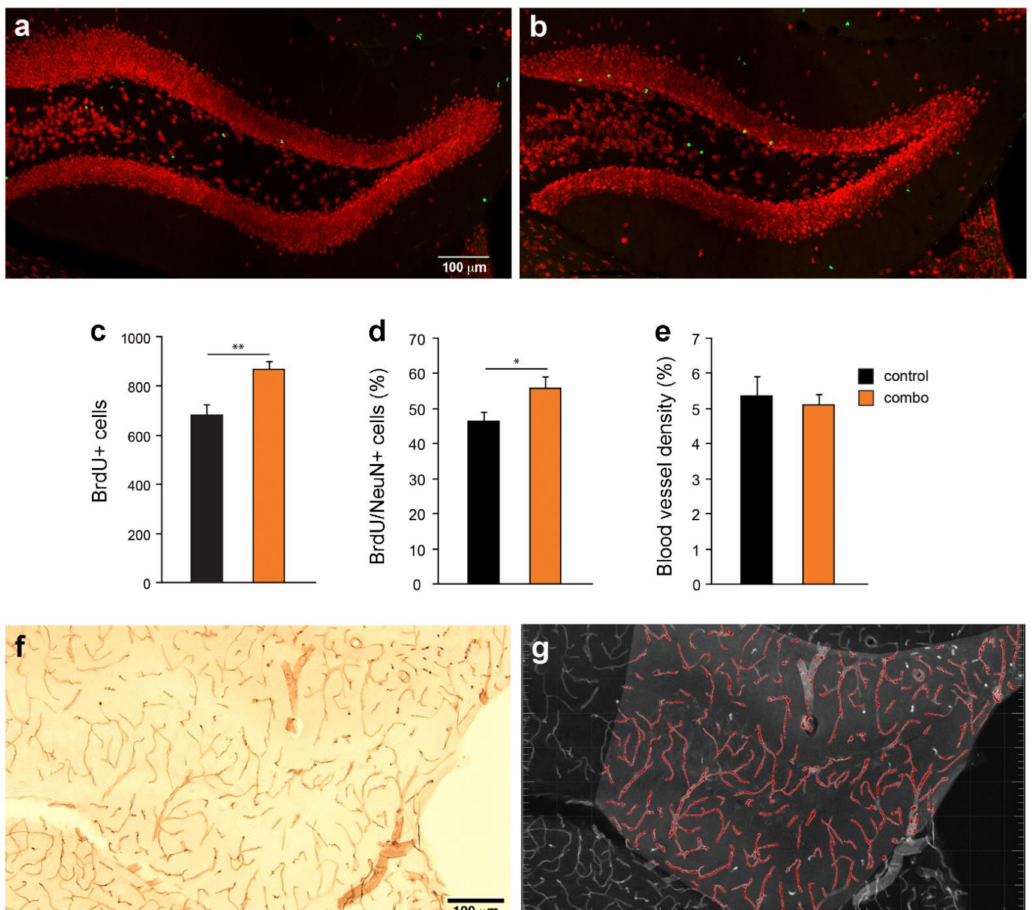
Figure 2. Effects of compound treatment on adult hippocampal neurogenesis and angiogenesis in the dentate gyrus in middle-aged mice. ( a , b ) Photomicrographs show double-labeling for BrdU (green) and NeuN (red) of coronal hippocampal sections derived from ( a ) control and ( b ) combo-treated mice. ( c ) The number of BrdU + cells significantly increased in the combo as compared to the control group. ( d ) The percentage of BrdU + /NeuN + cells was significantly higher in the combo than the control group. ( e ) The density of DG blood vessels did not differ between the groups. ( f ) Photomicrograph of blood vessel labeling with CD31. ( g ) Processed image (blood vessels are identified in red) for vasculature analysis. * p < 0.05, ** p <